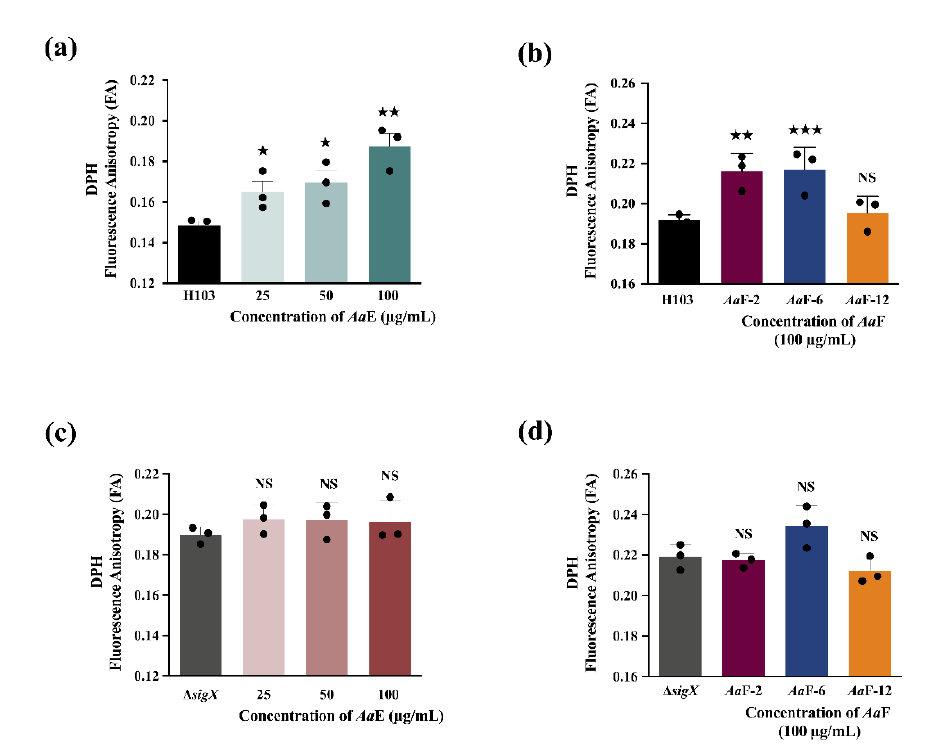
Figure 8. ( a ) Fluorescence anisotropy (membrane fluidity) measurements in P. aeruginosa H103 wild-type exposed to various concentrations of Aa E, and ( b ) Aa F-2 and Aa F-6 (diterpene-enriched fractions) and Aa F-12 at 100 µg/mL compared to H103 untreated condition. ( c ) Fluorescence anisotropy measurements in P. aeruginosa Δ sigX mutant exposed to various concentrations of Aa E, and ( d ) Aa F-2 and Aa F-6 (diterpene-enriched fractions) and Aa F-12 at 100 µg/mL compared to the Δ sigX untreated condition. Significant differences between mean values versus control were assessed via t- test using GraphPad Prism 8. ★★★ , p = 0.0001–0.001; ★★ , p = 0.001–0.01; ★ , p = 0.01–0.05; NS: (not significant), p > 0.05.